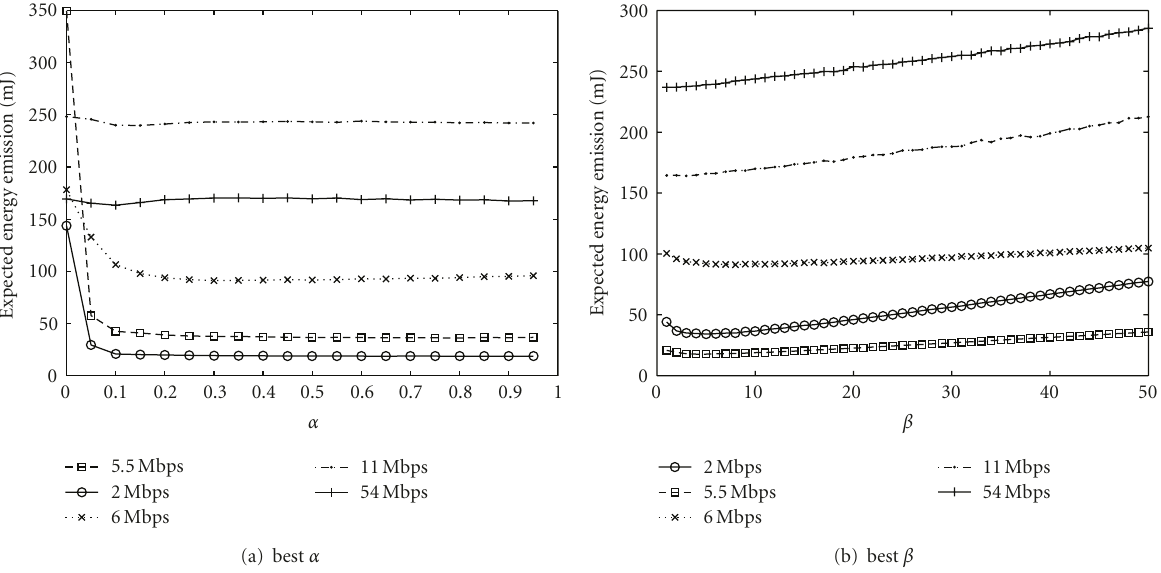
Figure 9: The best α and β for IEEE 802.11 with di ff erence data rates.